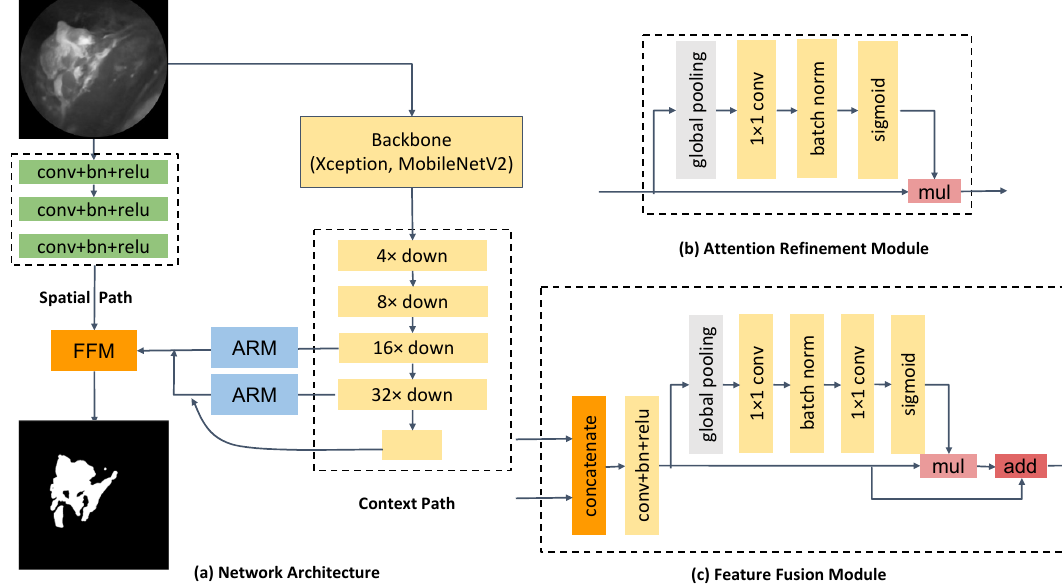
Figure 4. An overview of the bilateral segmentation network consisting of ( a ) network architecture, ( b ) components of the attention refinement module (ARM), and ( c ) components of the feature fusion module (FFM) [34].